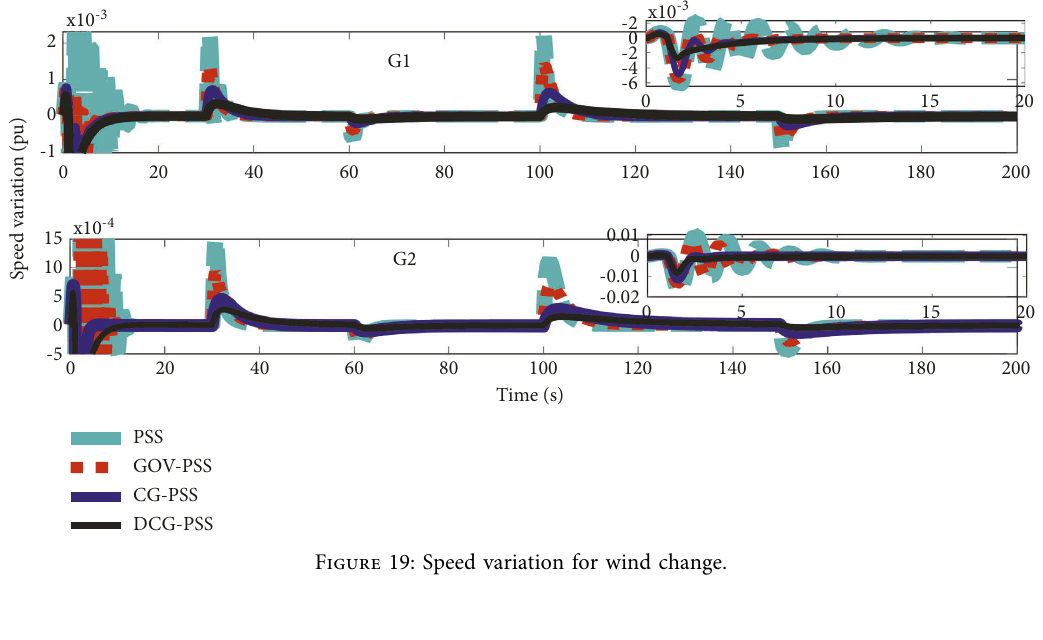
Figure 19: Speed variation for wind change.